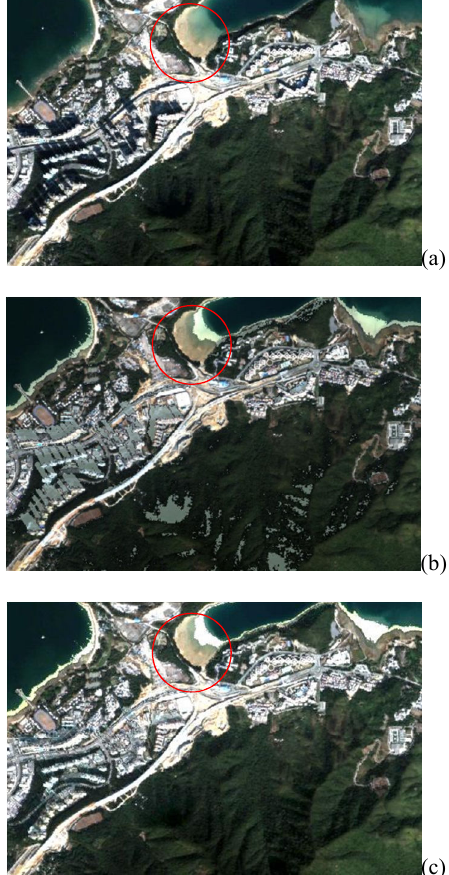
Figure 9. Ma On Shan - a) Original image; b) By Gamma Correction; c) By Linear-Correlation